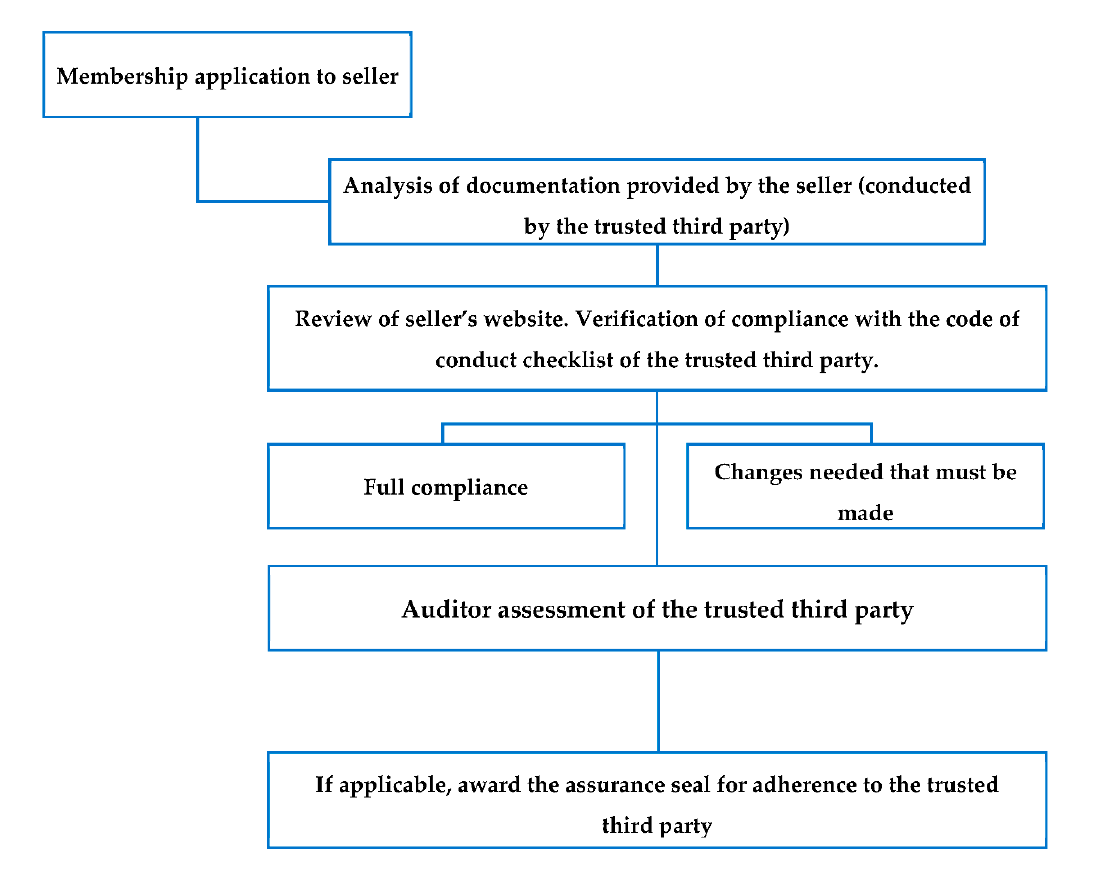
Figure 1. Adherence Process.